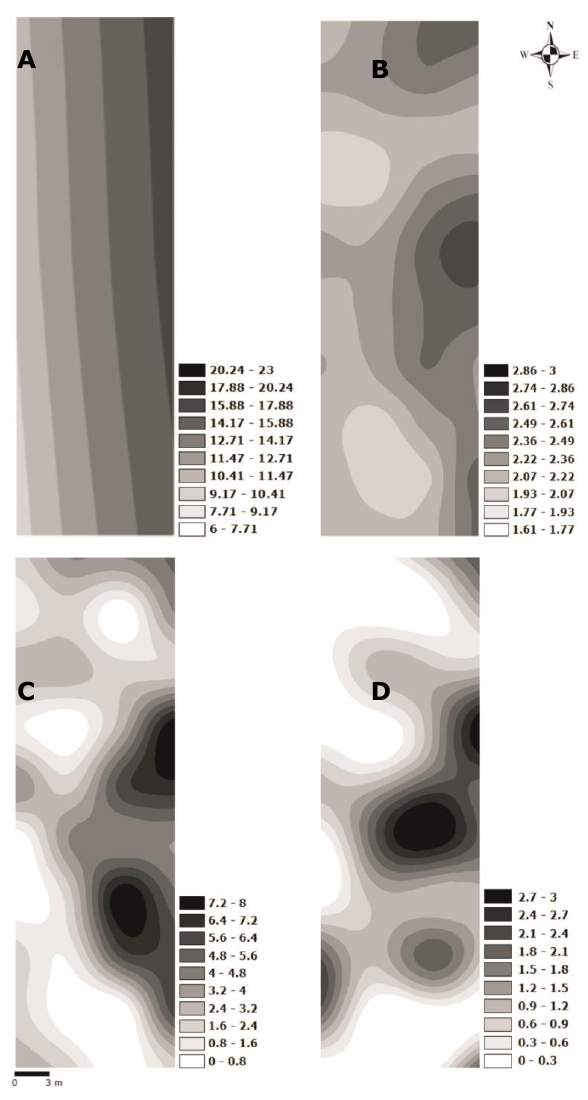
Fig. 10. Ash thickness interpolations according to the most accurate technique. From left to right. (A) 4 (LP1), (B) 16 (SK) with Ln data, (C) 34 (IMTQ) and (D) 45 days after the fire (CRS), data in mm, ln data for 16 day after the fire.